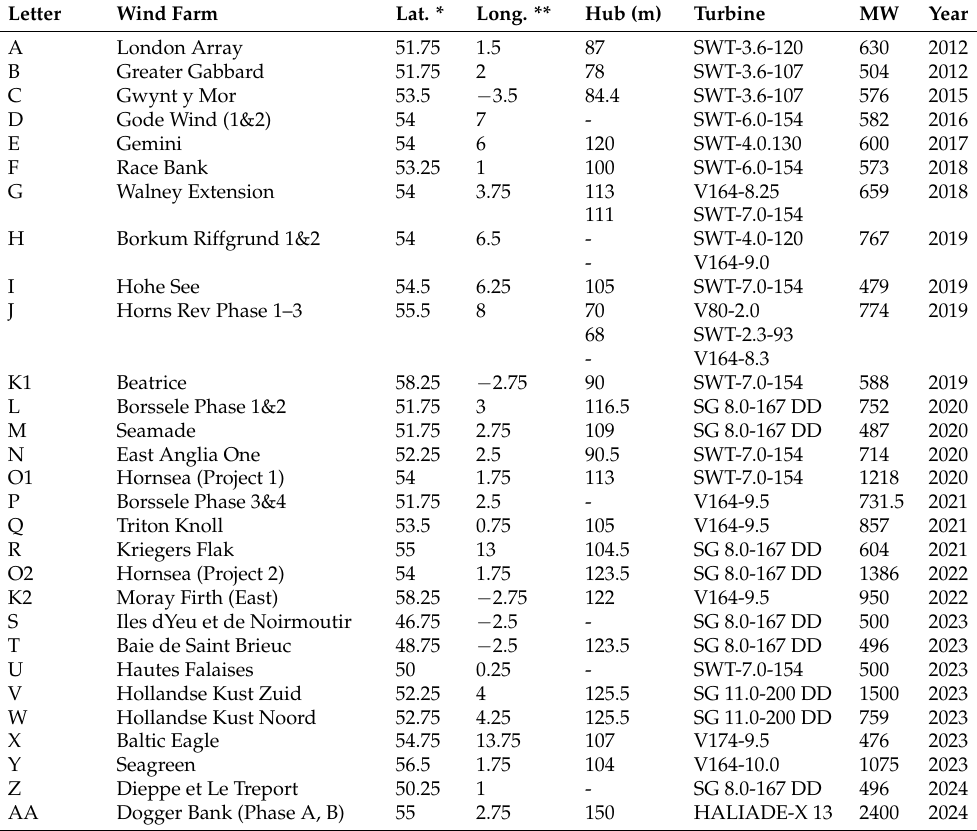
Table 1. Considered wind farms in this paper. * Latitude in °North ** Longitude in °. Negative values refer to a position west of Greenwich; positive values refer to a position east of Greenwich. The placeholders ‘-’ mark the locations where reliable hub heights were not available (see